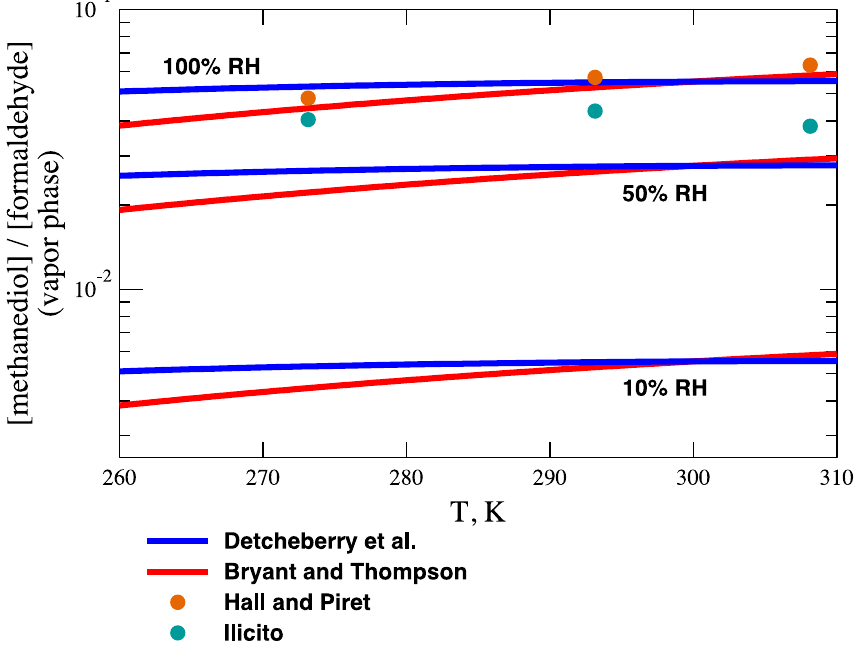
Figure 4. Temperature dependence of the formaldehyde K A . Data are from Detcheberry et al., Bryant and Thompson, and from Iliceto and Hall and Piret as quoted by Bryant and Thompson [64,65]. The saturation vapor pressure of water was calculated according to [66]. The red and blue traces were also calculated assuming three different values of relative humidity.